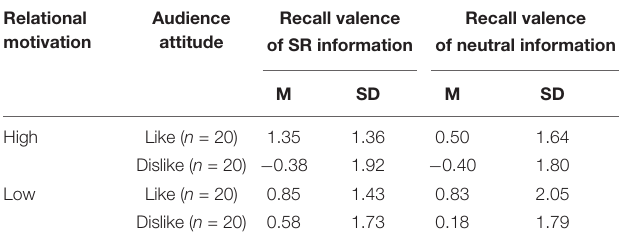
TABLE 3 | Recall valence as a function of relational motivation and audience